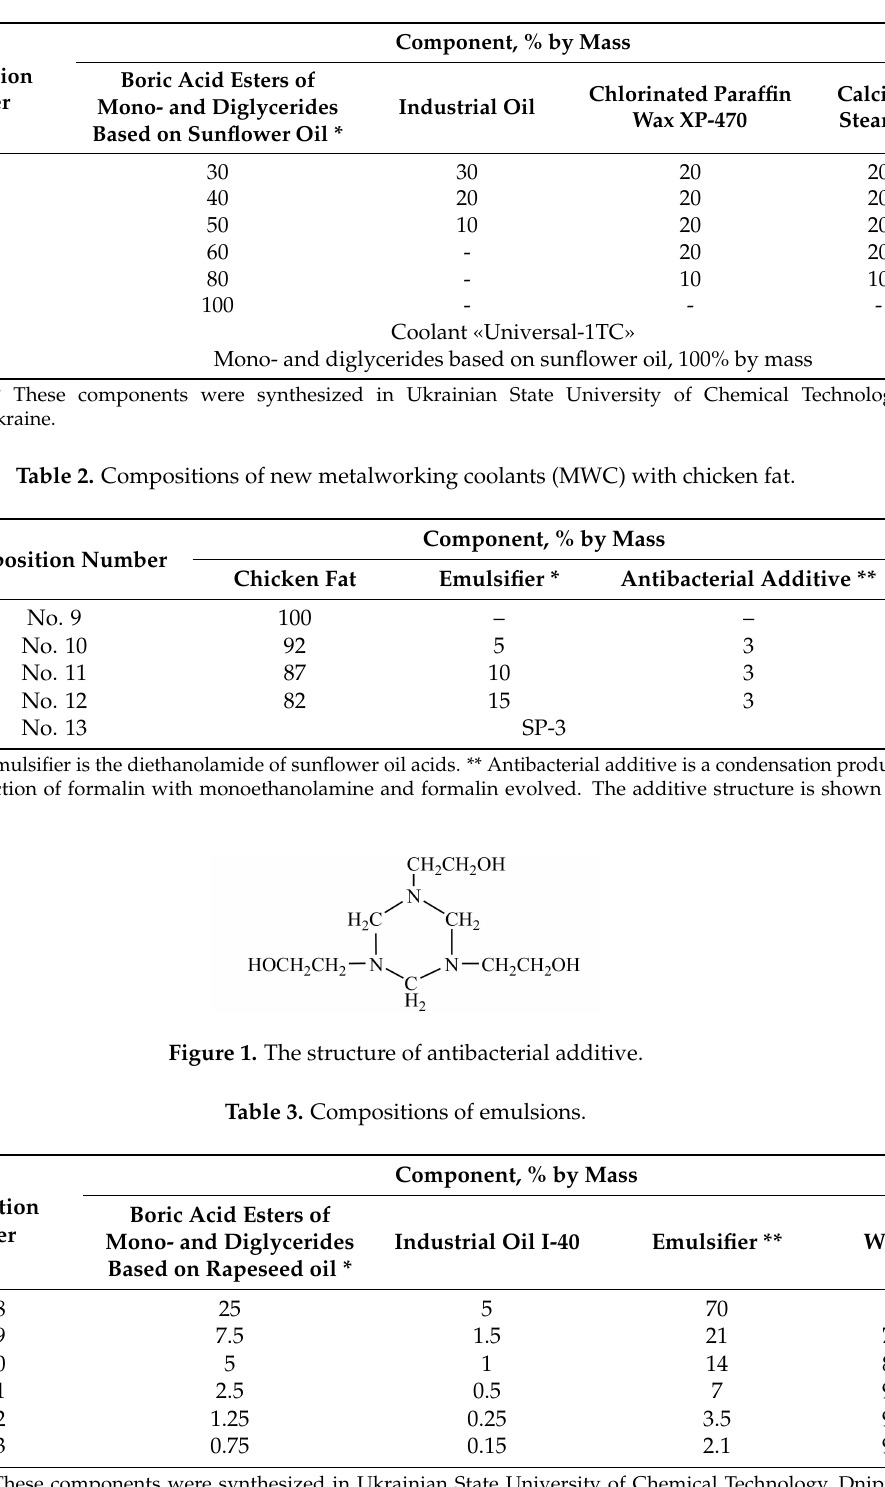
Table 1. Compositions of new metalworking coolants (MWC) with boric acid esters of mono- and diglycerides.